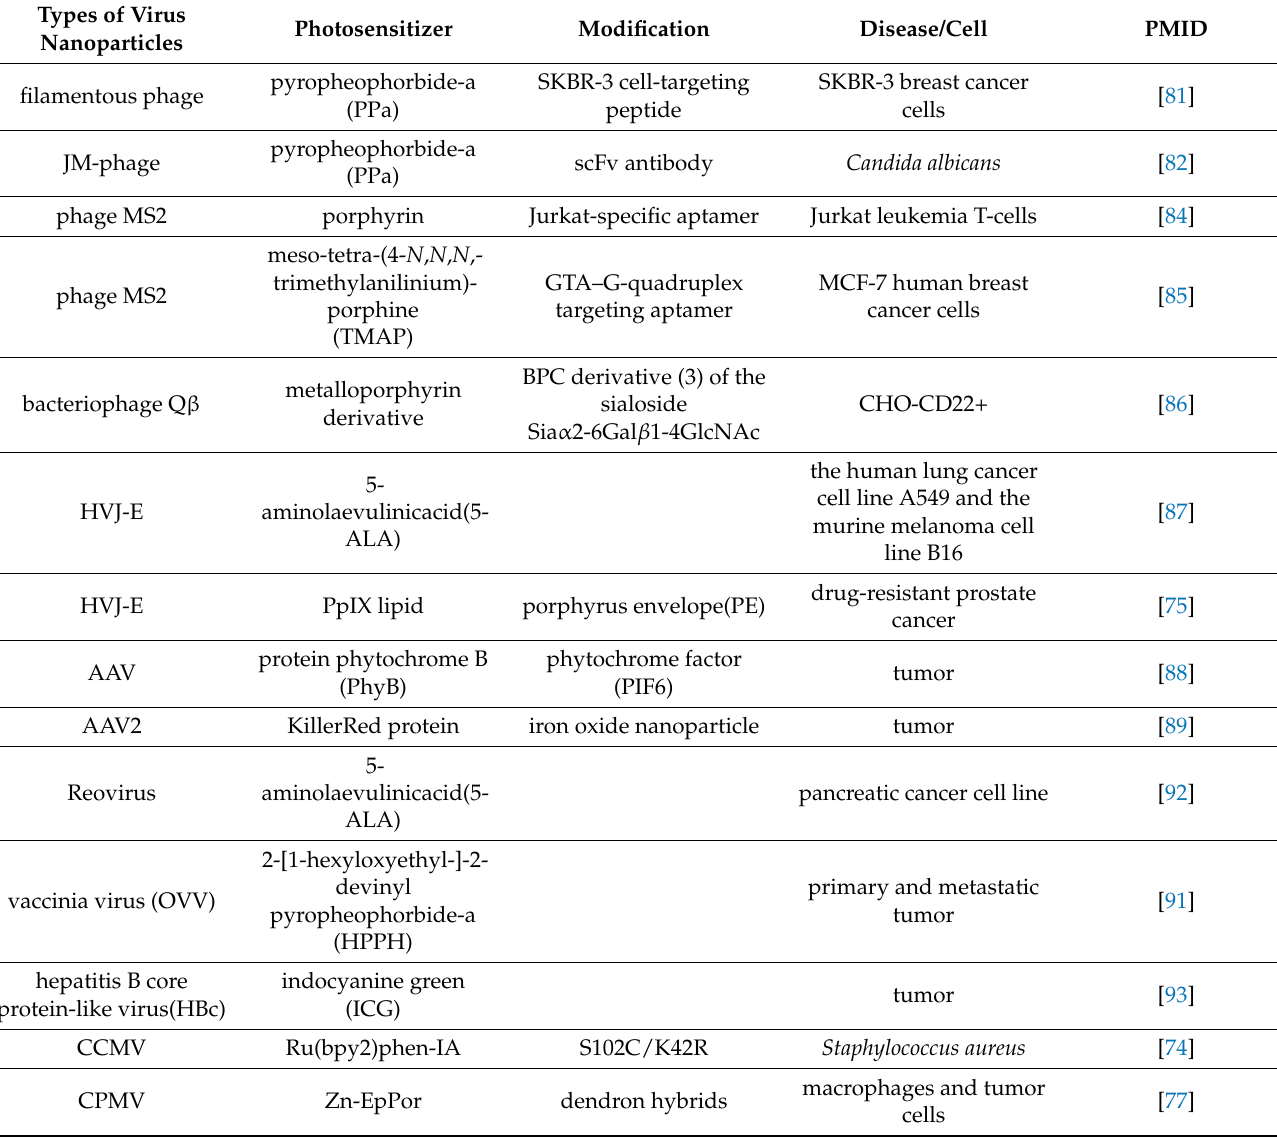
Table 1. The treatment of diseases through PDT by using viral nanoparticles as vectors. Types of